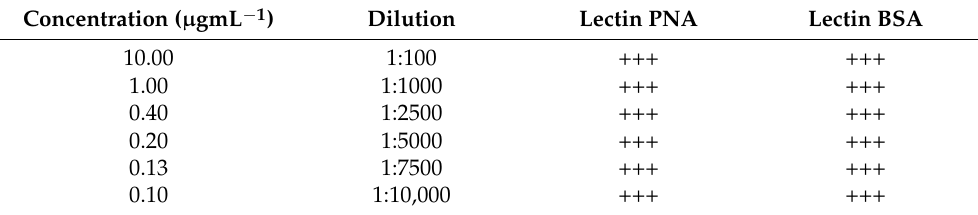
Table 1. Signal intensity of model carrageenan sample using the lectin concentration sequence. Concentration ( µ gmL − 1